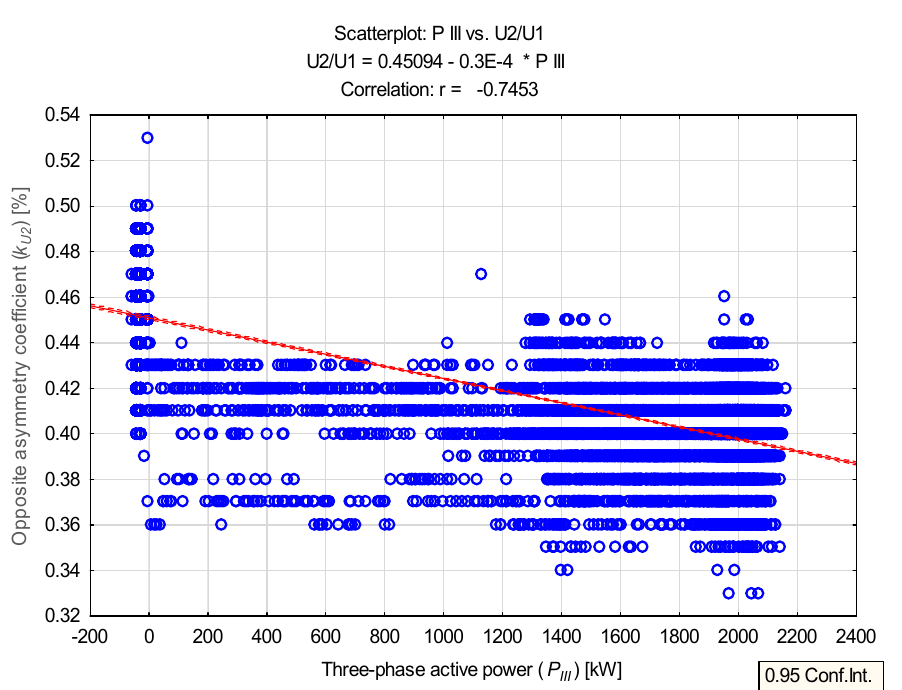
Figure 13. Diagram of the dependence of the value of the opposite voltage asymmetry coefficient ( k U 2 ) at the connection point on the three-phase active power ( P III ) generated by the wind power plant.